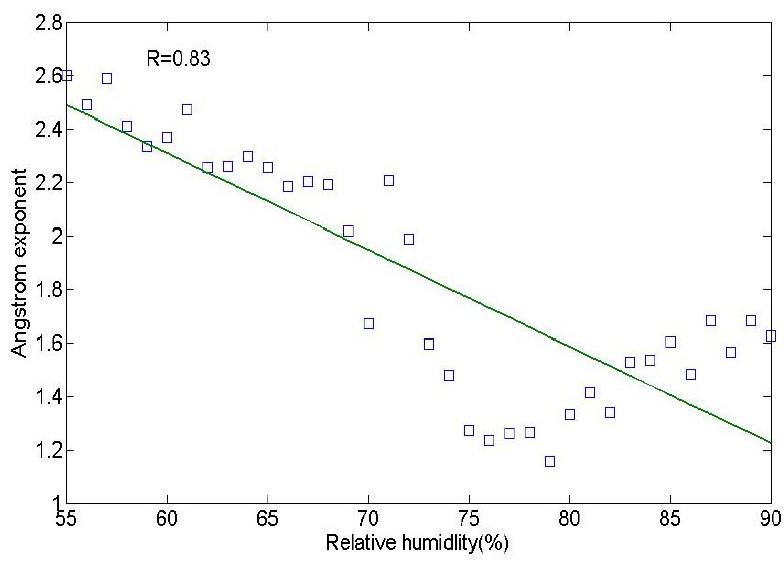
Figure 6. Comparison between relative humidity and Angstrom exponent.